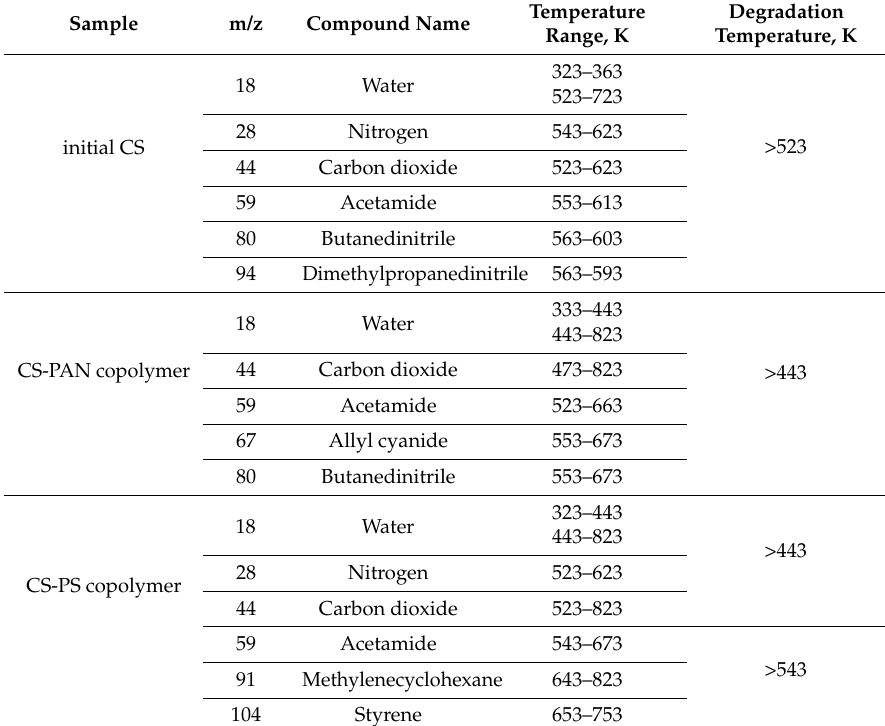
Figure 6. Coupled EGA-MS thermal degradation profiles of the: ( a ) initial CS powder ( b ) CS-PAN copolymer ( c ) CS-PS copolymer. Table 3. The main products formed in the temperature degradation of the: initial CS powder, CS-PAN copolymer and CS-PS copolymer.